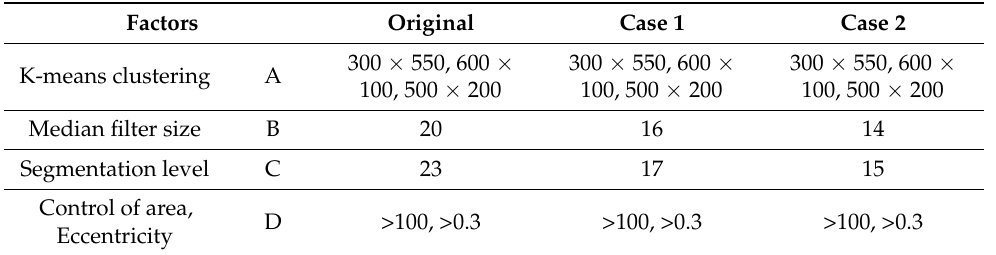
Table 6. The parameter optimization of three cases.